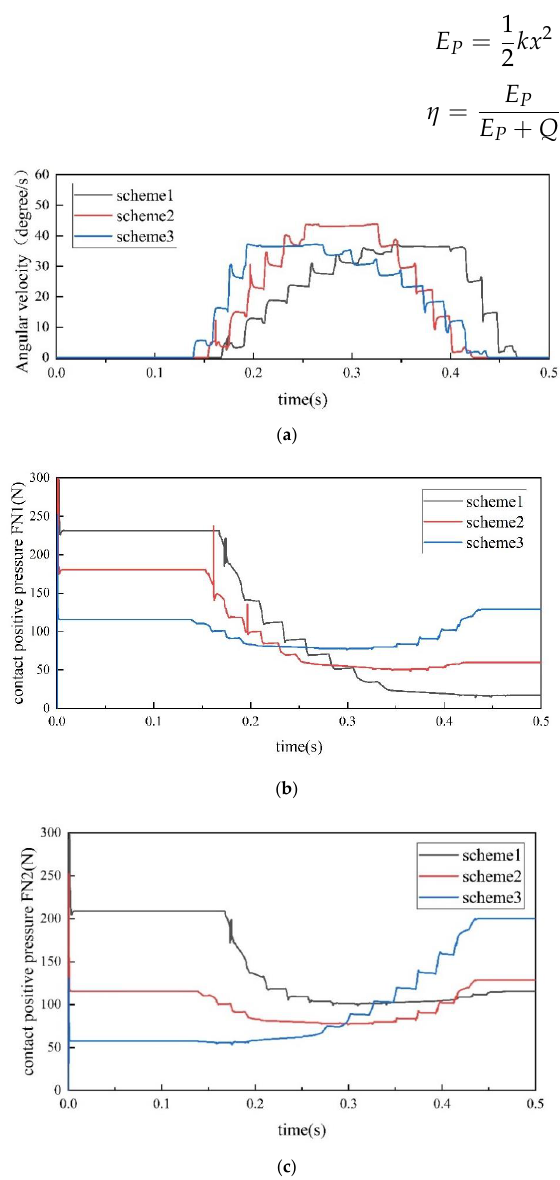
Figure 11. Parameter characteristics during flipping process of contact pin. ( a ) Flipping angular velocity of contact pin along its axis of rotation. ( b , c ) Time domain variation curves of contact positive pressures F N 1 and F N 2 .